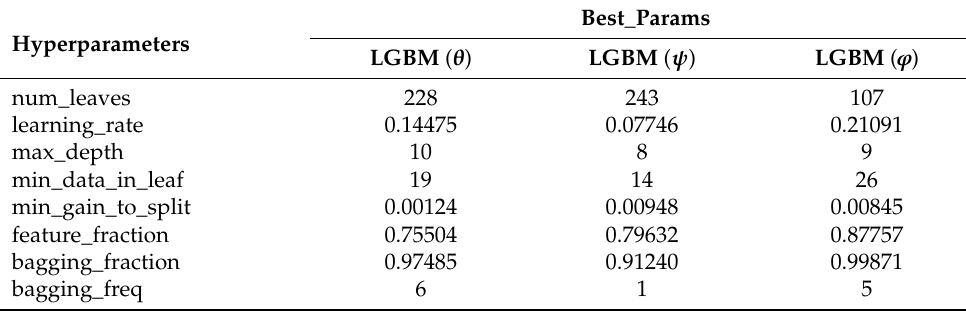
Table 3. Bayesian hyperparameters optimization results for single-view images.